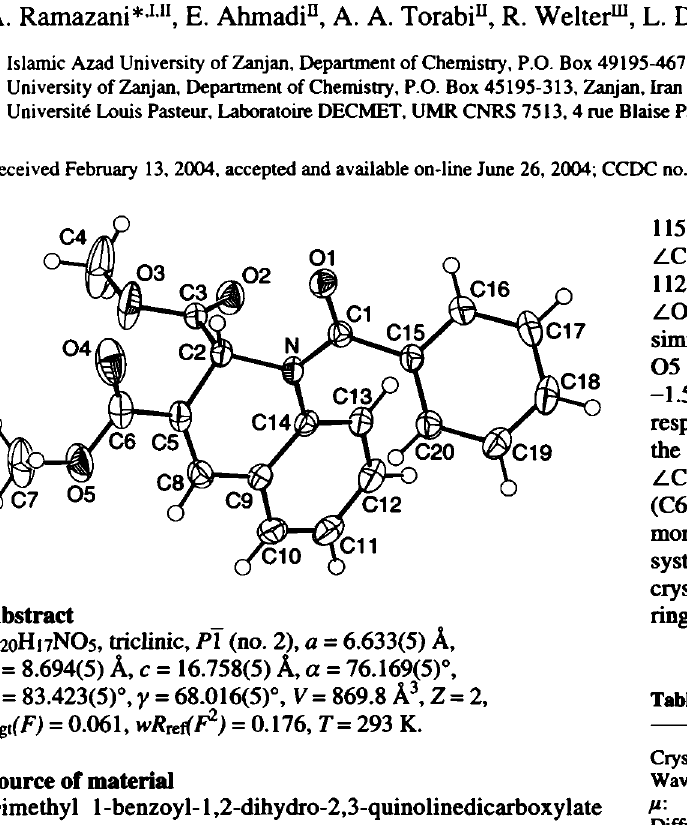
Table 1. Data collection and handling.